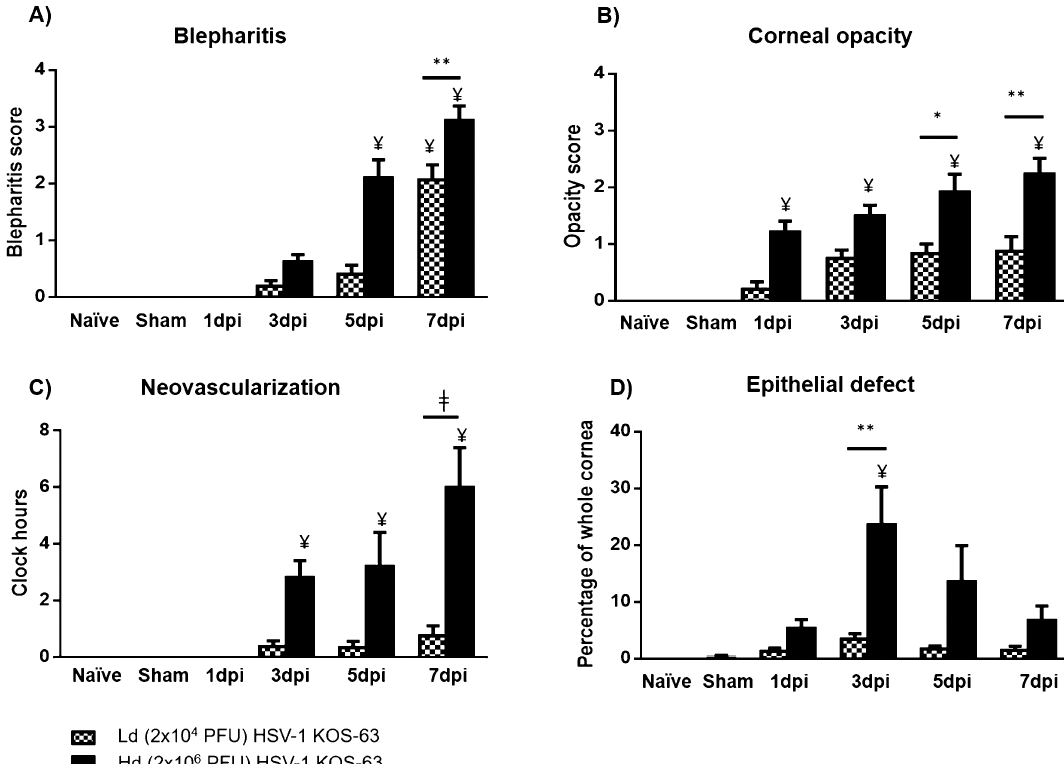
Figure 2. Comparison of clinical scores in naïve, sham-infected (1-day post scarification (dps)), and following corneal infection with Ld and Hd HSV-1 KOS-63 strain at 1, 3, 5, and 7 days post infection (dpi). ( A ) Blepharitis scores. At 1 dpi no blepharitis was observed but it increased gradually in both Hd and Ld infected mice. Blepharitis score was significantly higher in the Hd infected mice compared to Ld infected mice at 7 dpi (** p = 0.001). No blepharitis was observed in naïve and sham infected mice (1–7 dps), 1 dps is presented as representative. ( B ) Corneal opacity scores are demonstrated in both Ld and Hd infected mice. Opacity scores were higher in the Hd infected mice as compared to Ld infected mice and was significant at 5 dpi (* p = 0.04) and 7 dpi (** p = 0.003). No corneal opacity was observed in naïve and sham infected mice (1–7 dps), 1 dps is presented as representative. ( C ) Corneal neovascularization scores according to the clock hours area of vessel coverage. Neovascularization was more significant in the Hd infected mice compared to Ld infected mice at 7 dpi ( ǂ p < 0.0001). No corneal neovascularization was observed in naïve and sham-infected mice (1–7 dps), 1 dps is presented as representative. ( D ) Percentage of corneal epithelial defect was higher in the Hd infected mice compared to Ld infected mice in all time points and was significant at 3 dpi (** p = 0.001). No corneal opacity was observed in naïve mice. Minor epithelial defect remained after corneal scarification only at 1 dps, which was not statistically significant compared to naïve mice. Bars are showing mean ± SEM. ANOVA: p < 0.0001. ¥, demonstrates the statistical significance ( p < 0.05) between the marked column and naïve and sham-infected. p values are calculated by one-way ANOVA followed by Tukey’s multiple comparison